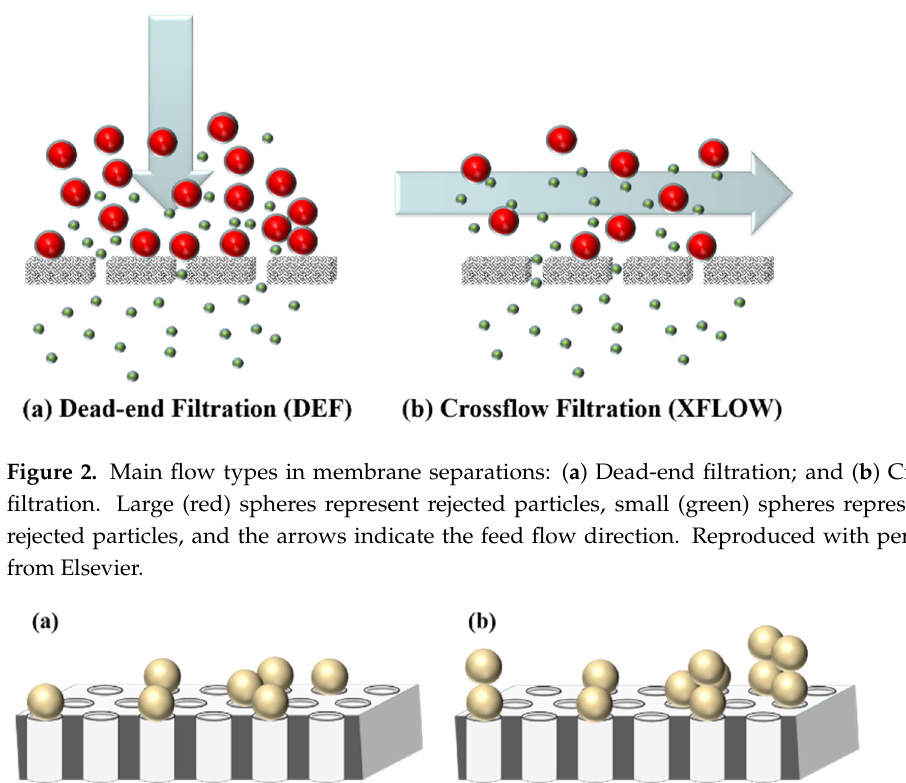
Figure 2. Main flow types in membrane separations: ( a ) Dead-end filtration; and ( b ) Crossflow filtration. Large (red) spheres represent rejected particles, small (green) spheres represent non- rejected particles, and the arrows indicate the feed flow direction. Reproduced with permission from Elsevier.